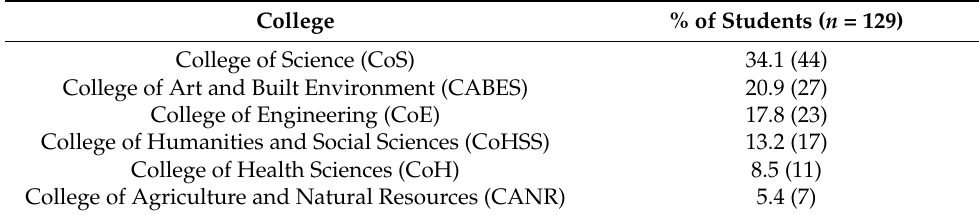
Table 2. Distribution of students from the various colleges.